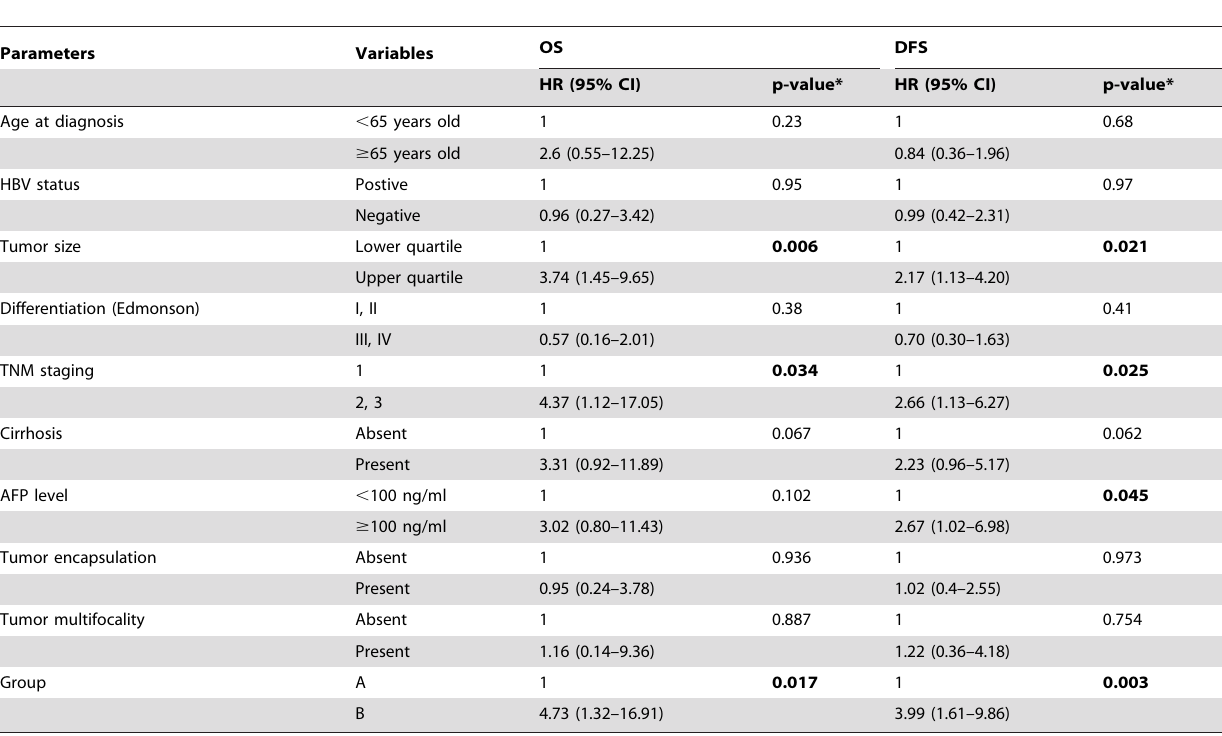
Table 2. Univariate analysis of clinicopathological variables for overall survival (OS) and disease-free survival (DFS) in 58 patients (one patient did not have survival